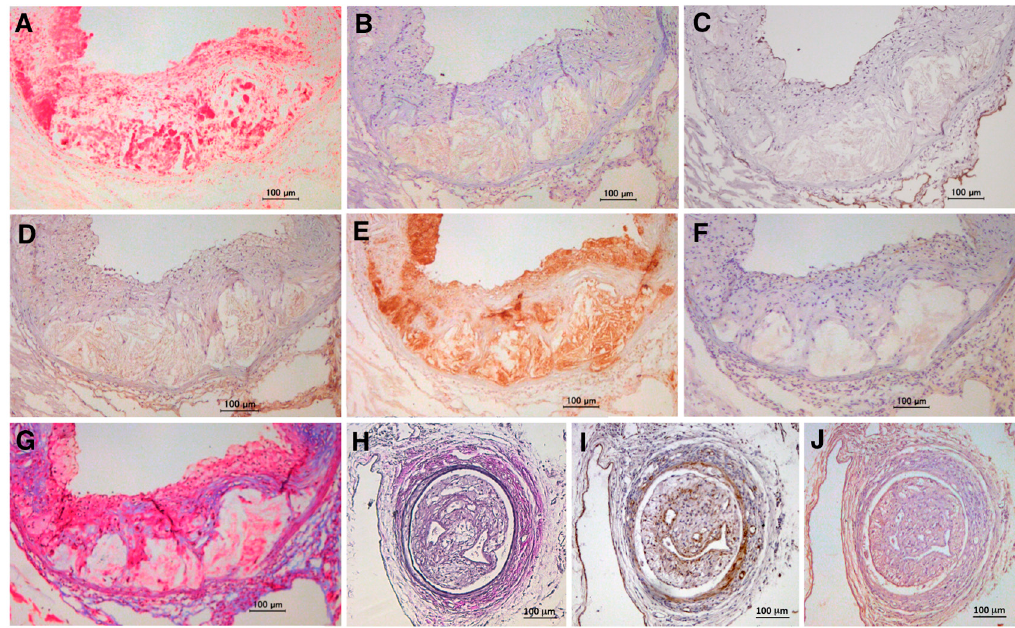
Figure 4. Expression of TSG-6 in atherosclerotic and restenotic lesions in ApoE-deficient mice. TSG-6 is expressed at high levels in aortic atherosclerotic lesions ( A – G ) and femoral artery restenotic lesions after wire injury ( H – J ) in ApoE-deficient mice fed a high-cholesterol diet. Tissues were immunostained with Oil Red O (Wako Pure Chemical Industries, Osaka, Japan; ( A )); anti-TSG-6 antibody (Bioworld Technology, St. Louis Park, MN, USA; ( B , J )); anti-podocalyxin antibody (Life Technologies, Carlsbad, CA, USA; ( C )); anti-pentraxin-3 antibody (Bioss Antibodies, Woburn, MA, USA; ( D )); anti-MOMA-2 antibody (Millipore, Billerica, MA, USA; ( E )); anti- α -SMA antibody (Sigma, St. Louis, MO, USA; ( F , I )); Masson’s Trichrome (Muto Pure Chemicals, Tokyo, Japan; ( G )); and Elastica-Van Gieson (Muto Pure Chemicals; ( H )). Hematoxylin was used for nuclear staining. Bar = 100 µ m. ( C ) Podocalyxin is used as an EC marker. ( G ) Masson’s Trichrome is used to stain collagen fibers in blue. Panels ( A – G ) show unpublished data from our previous experiments [10], and panels ( H – J ) show unpublished data from our new experiments.